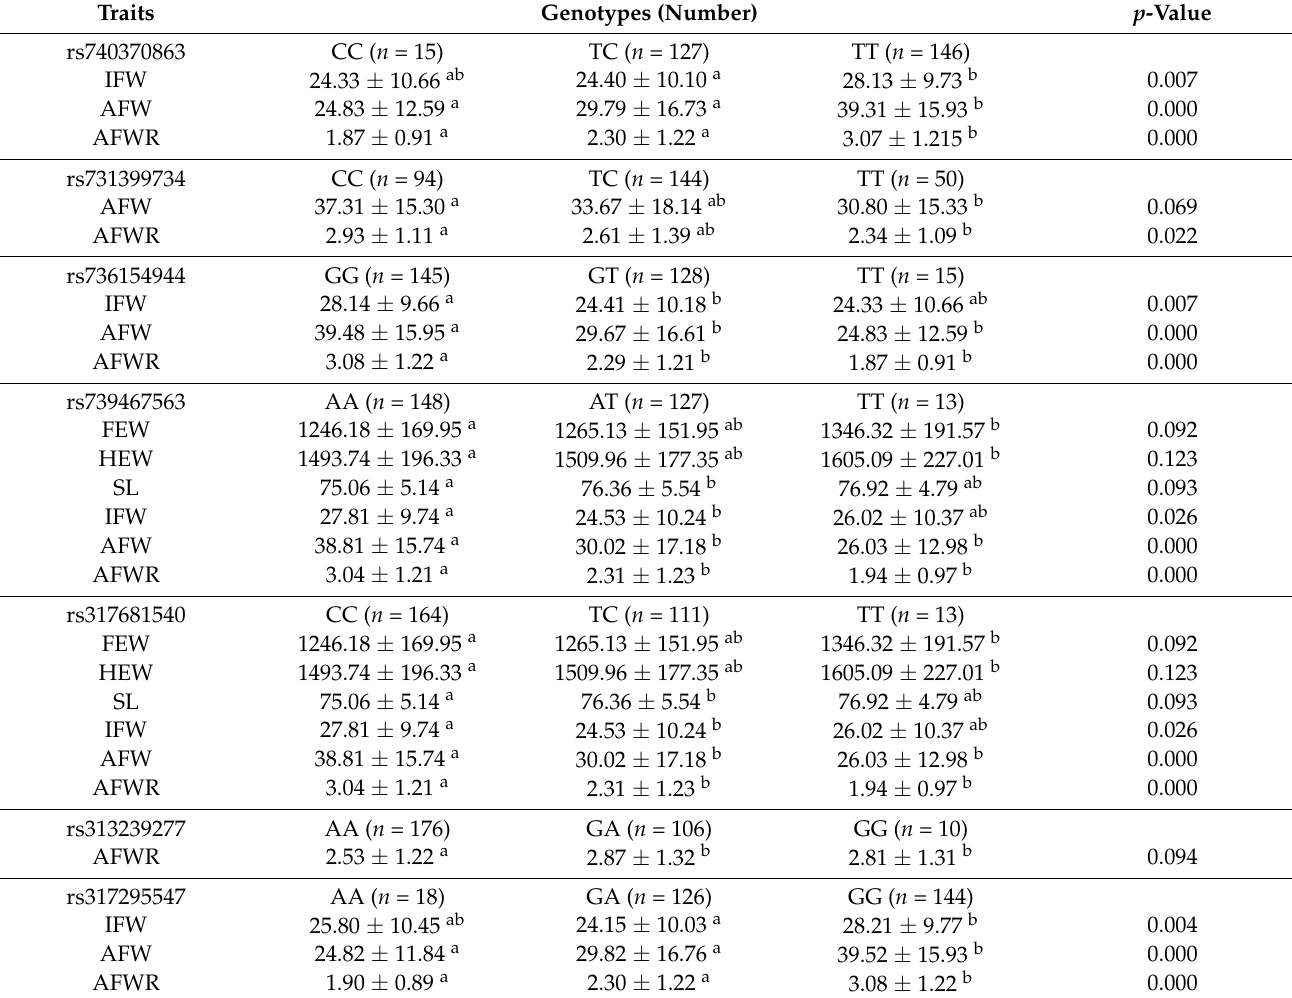
Table 2. Associations between PROS1 5 (cid:48) flanking region SNPs and carcass